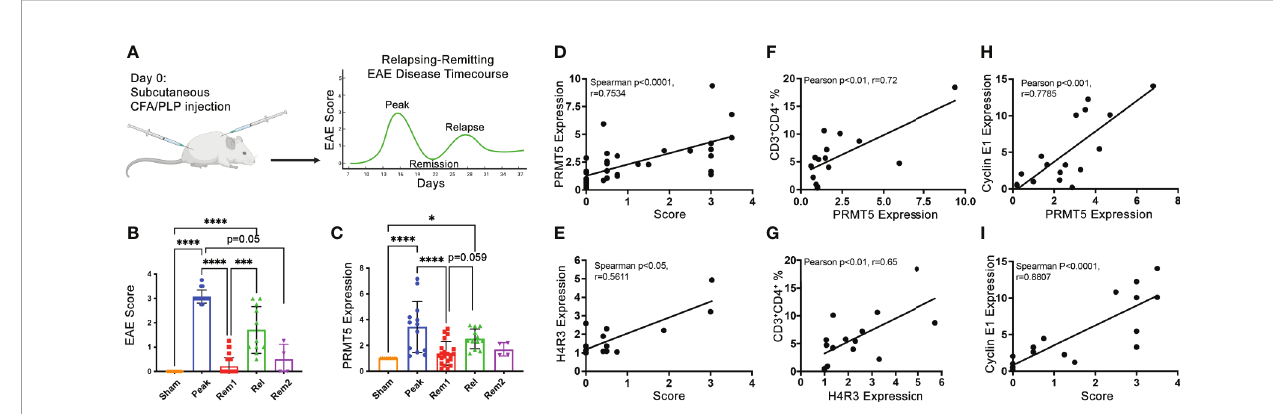
FIGURE 3 | PRMT5, SDM and Cyclin E1 expression in CNS in fi ltrates correlate with RR EAE disease severity and/or progression. (A) Experimental design diagram: graphical representation of the typical EAE course in SJL mice injected with PLP (139-151) . Created with BioRender.com. For actual EAE data in mice used for data in B through I, please see Figure S3 . (B) Mean scores calculated from mice injected with PBS instead of PLP (sham), mice collected at peak disease [day (D) 14], in remission 1 (considered in remission if score dropped ≥ 1.5, D19-D25), in relapse (considered in relapse if score dropped by 1.5 or more and then rose by 1 or more, D28-33), in remission 2 (considered rem2 if mouse went through relapse and back to remission). (C) CNS in fi ltrating cells were collected at the times described in (B) and analyzed by immunoblot for PRMT5. (D – I) CNS in fi ltrating cell protein from individual mice or pooled from multiple mice (for conditions with low in fi ltrating CNS cell numbers) were used as samples for protein analyses of PRMT5, H4R3 and Cyclin E1 immunoblot and one aliquot was analyzed by fl ow cytometry for immune cell composition (and correlation analyses were performed. CNS in fi ltrating cell protein from individual mice or pooled from multiple mice (for conditions with low in fi ltrating CNS cell numbers) were used for protein analyses. A minimum of ~400,000 cells per sample were used and equal amounts of protein (5-15 m g) loaded and data were normalized to sham (C – I) . (D, E) Spearman correlation of score vs. (D) PRMT5 or (E) H4R3 expression. (F, G) Pearson correlations were done between CD3 + CD4 + T cell % and (F) PRMT5 or (G) H4R3 SDM expression in in fi ltrating CNS cells. (H, I) Correlation between Cyclin E1 expression and (H) PRMT5 expression or (I) score in in fi ltrating CNS cells. Pearson correlations were done for CD3 + CD4 + T cells vs. protein expression or protein vs. protein. Spearman correlations were done for scores vs. protein expression. For (D – I) , n=15-36 with technical replicates from n=59-83 total mice from 2-4 independent experiments. Graphs (B, C) quantify relative expression normalized to actin loading control and combined from 4 independent experiments, (9-18 sham, 13-16 peak, 21-35 rem1, 11-12 relapse, 4 rem2), biological samples were kept separate if possible, but pooled for each timepoint as necessary for each experiment, 1-2 technical replicates/experiment, graphs represent mean ± SD, *p < 0.05, ***p < 0.001, ****p <